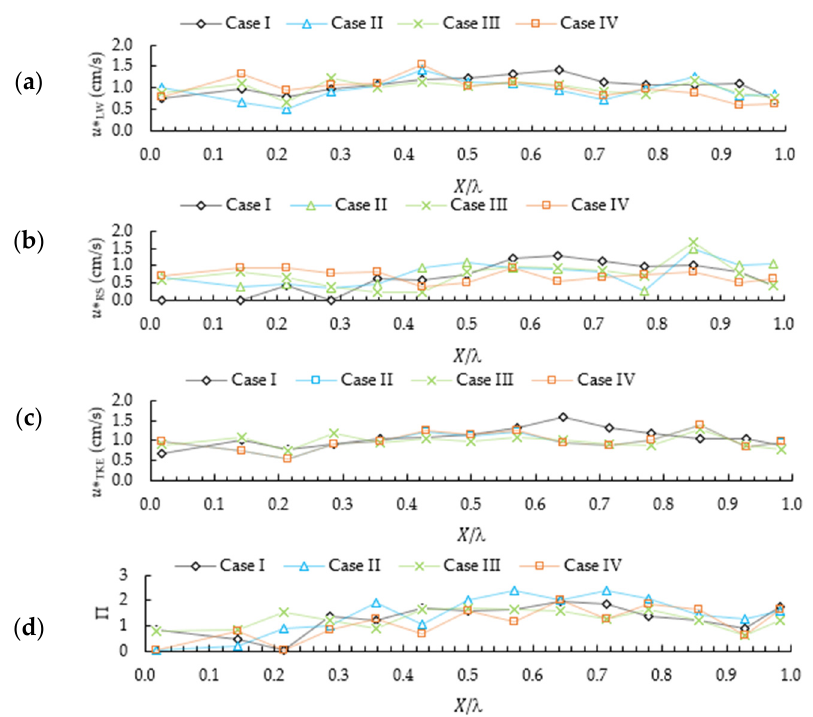
Figure 5. ( a ) Shear velocity according to the law of wall ( 𝑢 ∗ (cid:3013)(cid:3050) ), ( b ) shear velocity according to the Reynolds stress ( 𝑢 ∗ (cid:3019)(cid:3020) ), ( c ) shear velocity according to the turbulent kinetic energy ( 𝑢 ∗ (cid:3021)(cid:3012)(cid:3006) ), and ( d ) Coles wake parameter ( Π ) along the channel centerline from upstream to downstream of the bed-